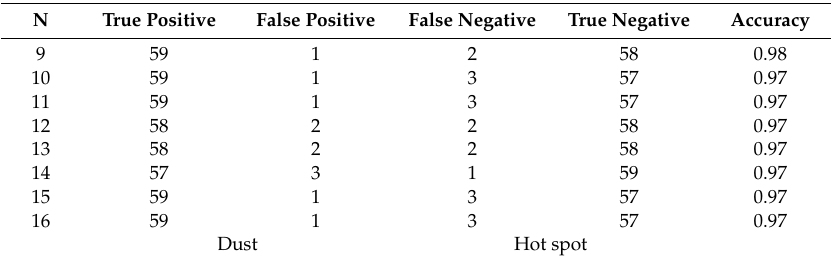
Table 5. Confusion matrix of tests with augmentation techniques.